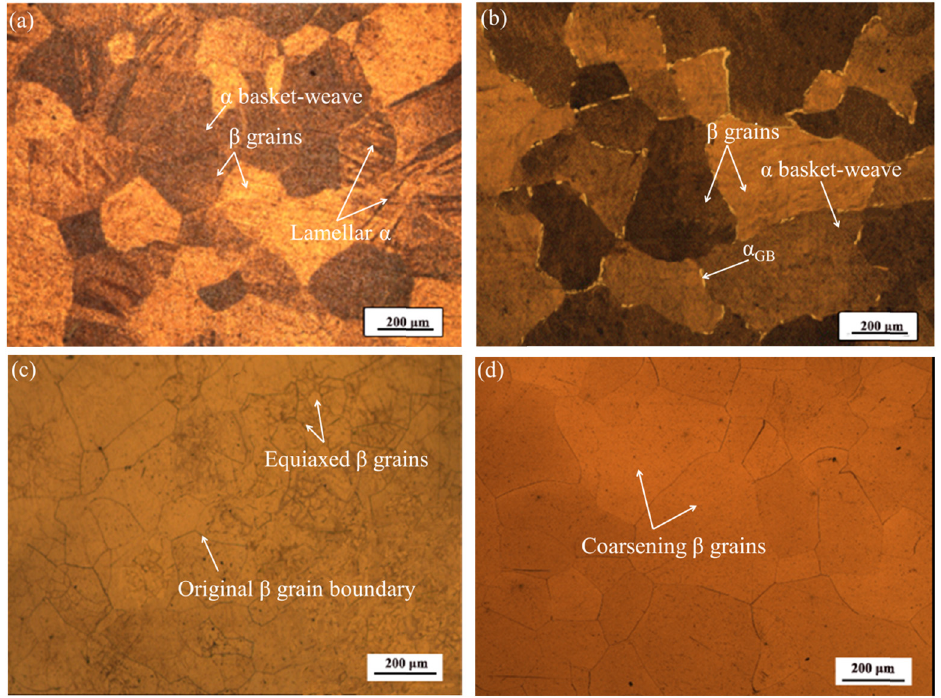
Figure 3: Microstructures of sample solutions treated at different temperatures with water cooling: ( a ) 700°C, wc; ( b ) 760°C, wc; ( c ) 820°C, wc and ( d ) 880°C,